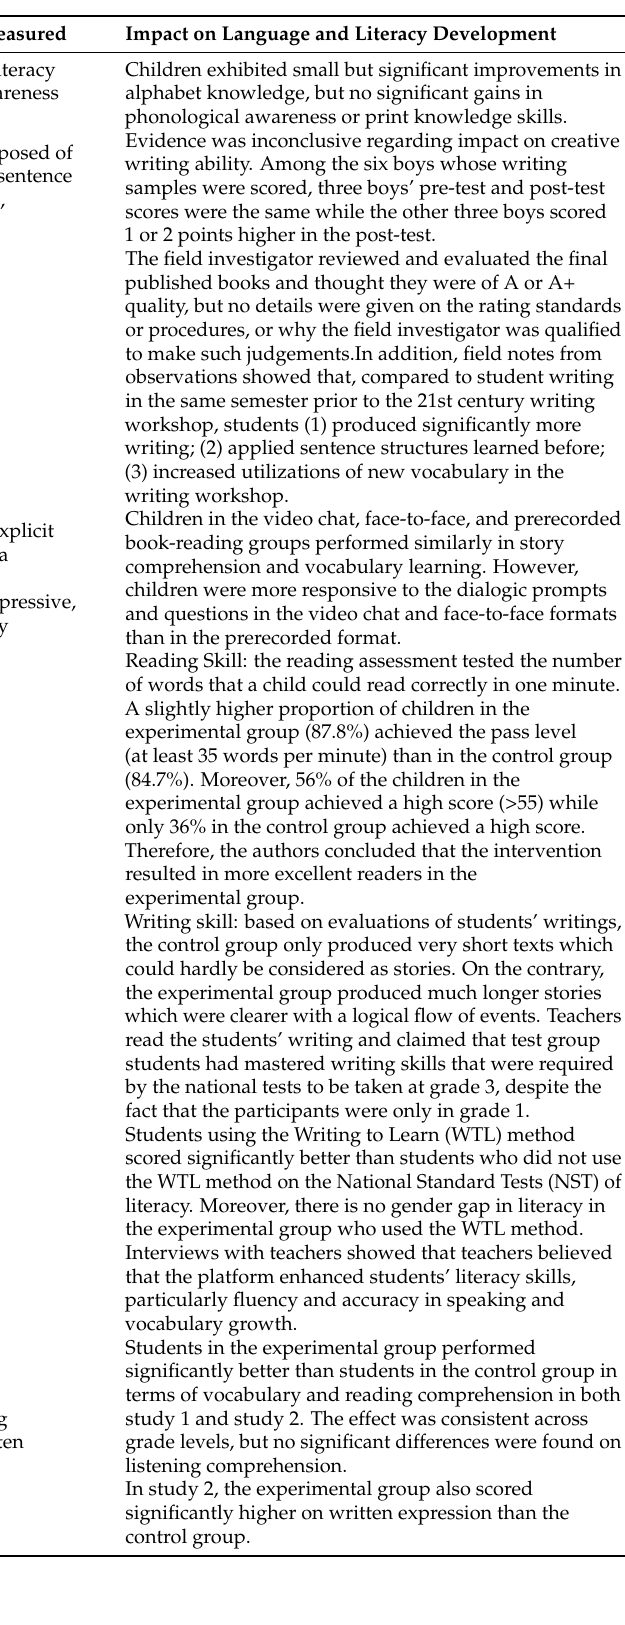
Table 5. Effects of integrating social media tools on language and literacy